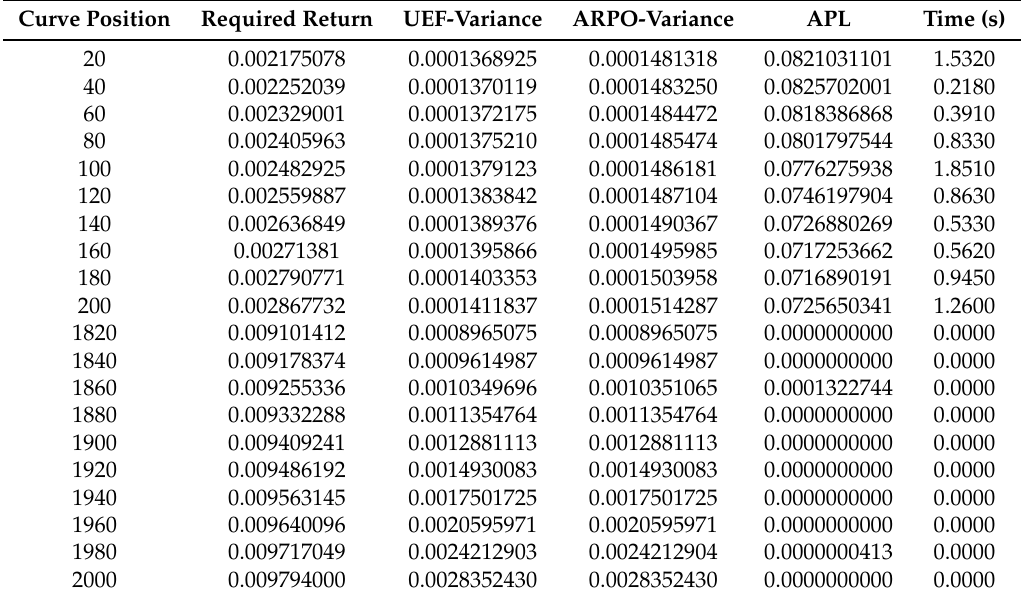
Table 3. DAX 100 Stock Market (Germany).